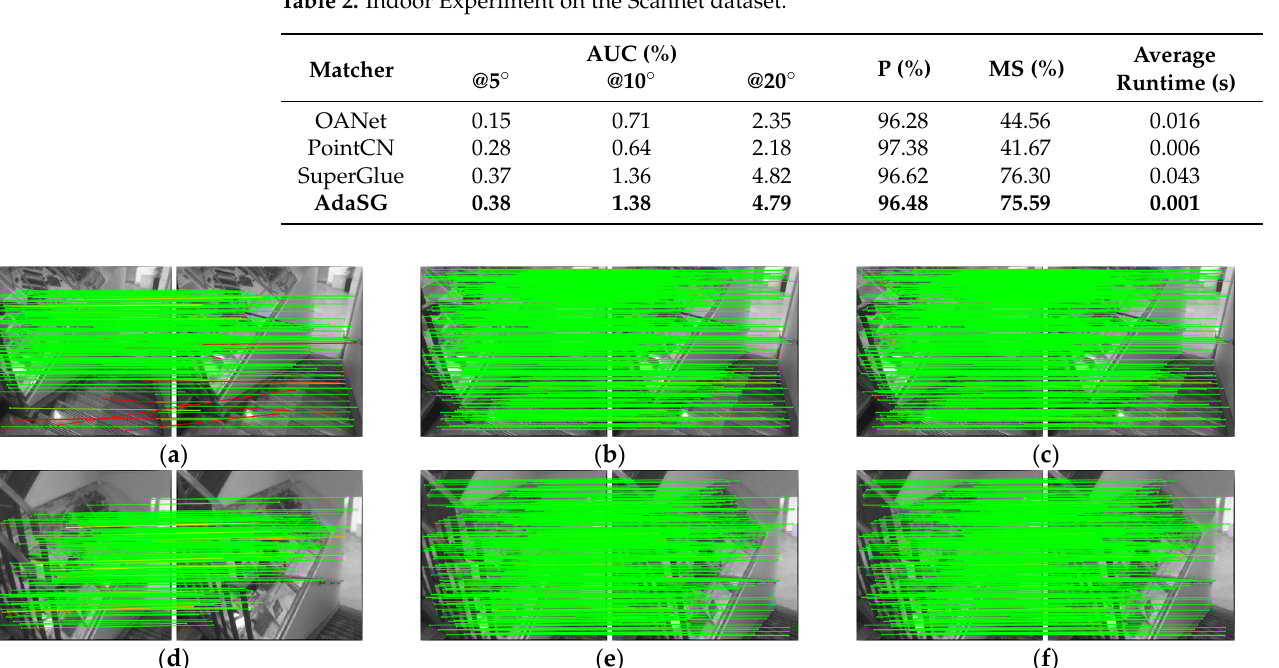
Figure 8. The whole system.